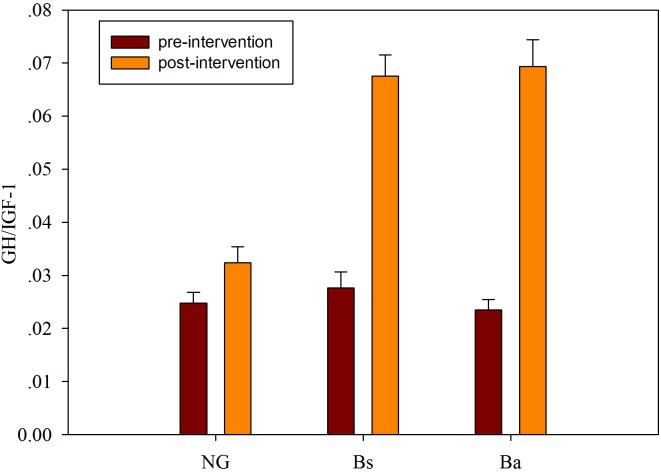
The GH/IGF-I level changes after intervention among different groups.